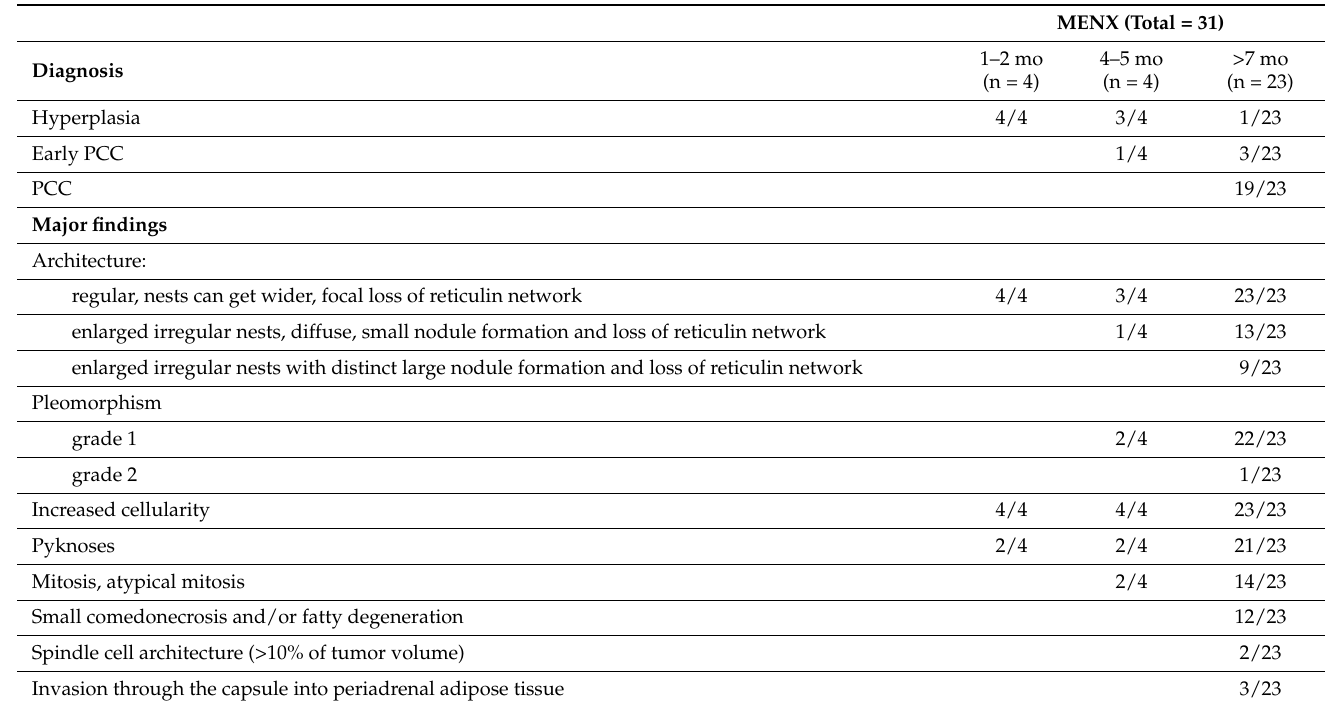
Table 1. Overview of the histomorphological characteristics of MENX